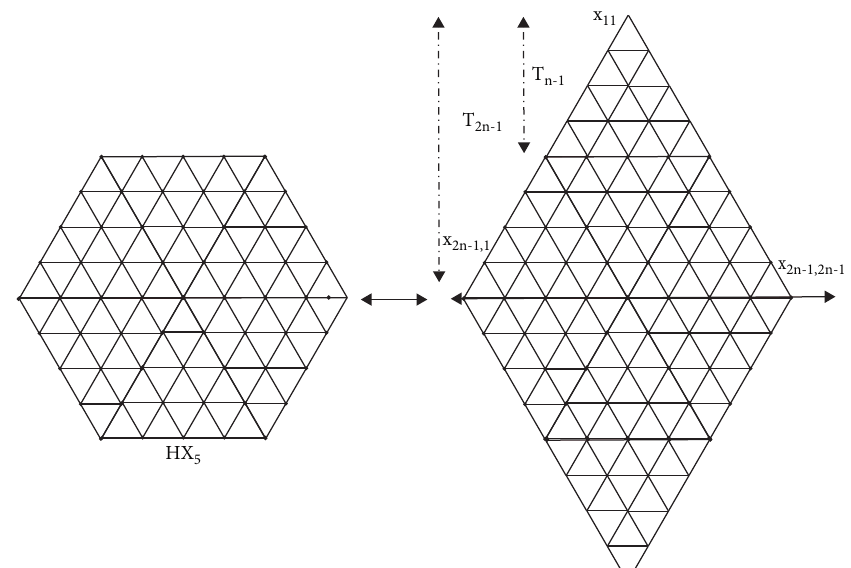
Figure 3: Hexagonal network HX